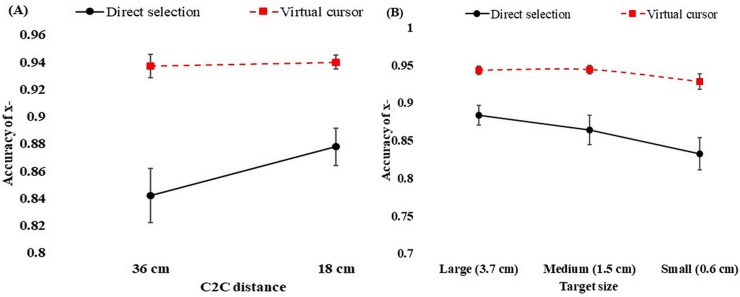
Accuracy of x-position in the c2c distance (A) and interactions of target size and technique (B). The error bars represent standard error of the mean.